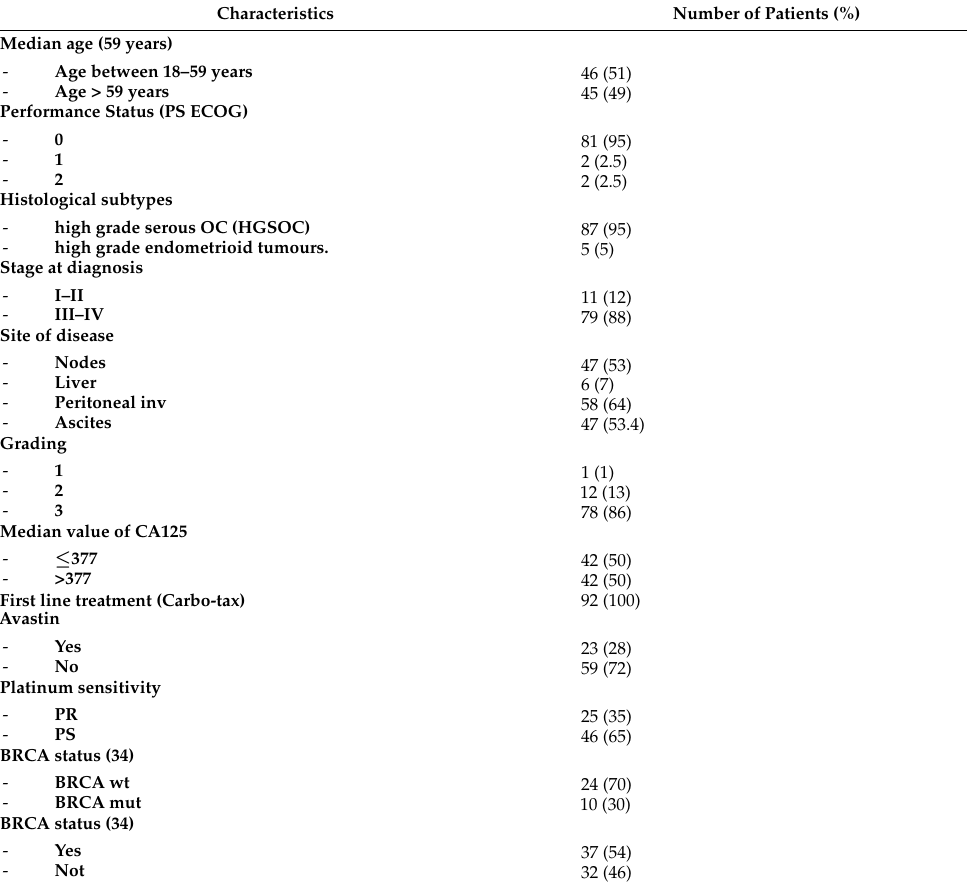
Table 1. Basal characteristics of patients. For each predefined prognostic factor, we reported a descriptive table on the number of patients and the respective percentage for a single